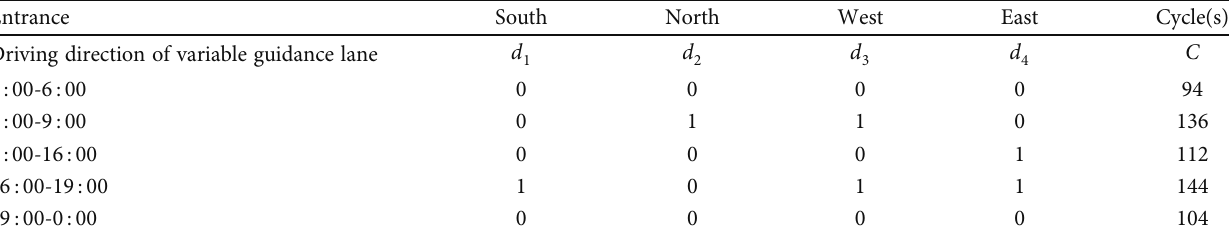
Table 4: The bi-level model optimization